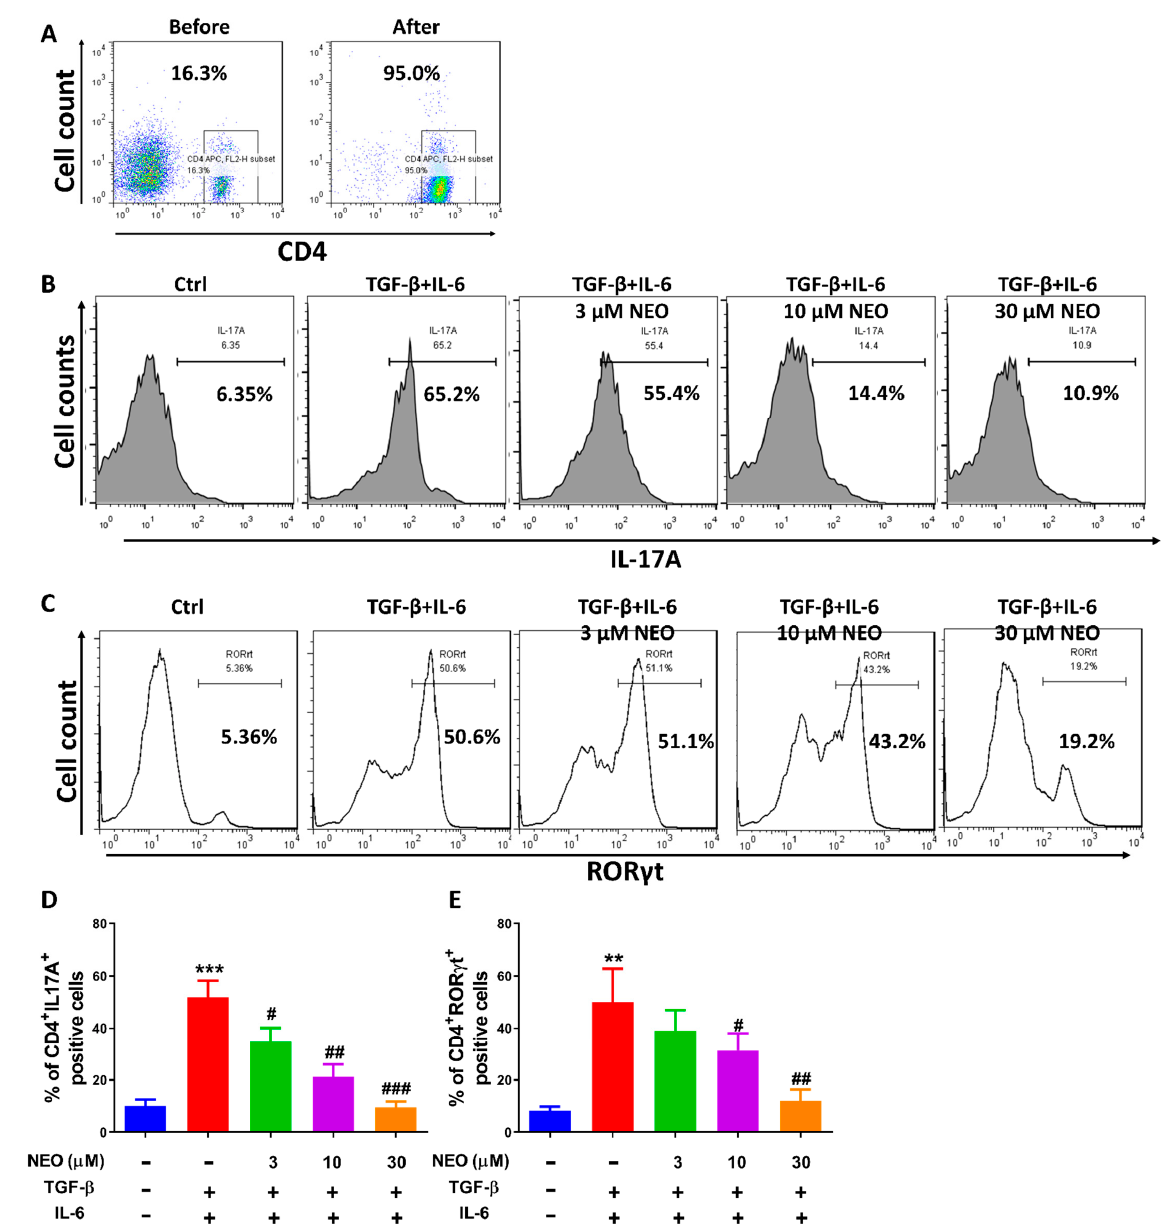
Figure 5. NEO restricted the differentiation of CD4 + T cells to Th17 cells. ( A ) Purity of CD4 + T cell before and after magnetic separation. ( B , D ) Effect of NEO on the percentage of population of CD4 + IL-17A + T cells. ( C , E ) Effect of NEO on the percentage of population of CD4 + ROR γ t + T cells. The results represent three independent experiments. ** p < 0.01 and *** p < 0.001 indicated that the differences were statistically significant vs. control group; whereas, # p < 0.05, ## p < 0.01 and ### p < 0.001 declared statistically significant differences vs. TGF- β and IL-6 group (n =